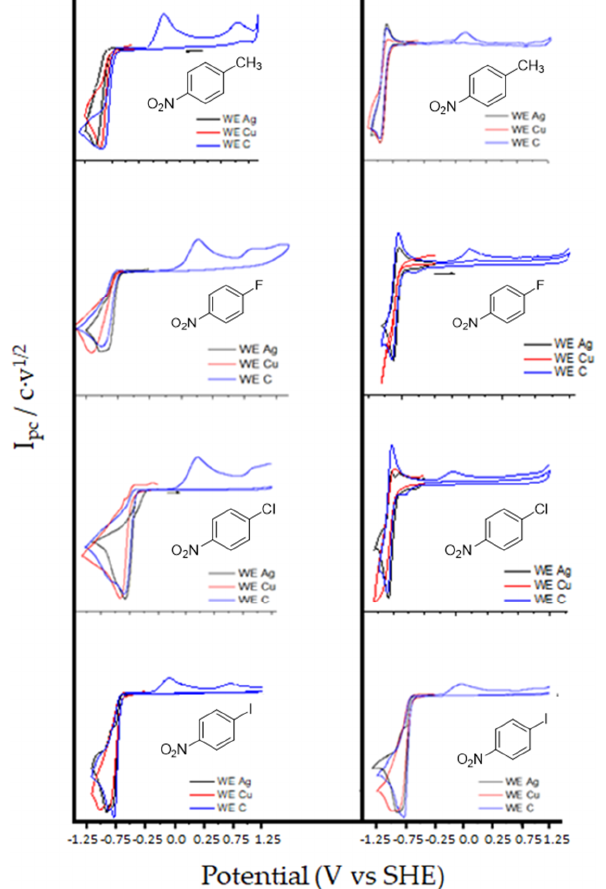
Figure 3. Cyclic voltammetry of 10 mM p -nitro compounds 1 - 4 with Ag (black line), Cu (red line) and C (blue line), under CO 2 atmosphere. Scan rate: 0.5 V · s − 1 . Solution of DMF / 0.1M TBA BF 4 (left) and solution of 3 mL EMIM TFSI (right).